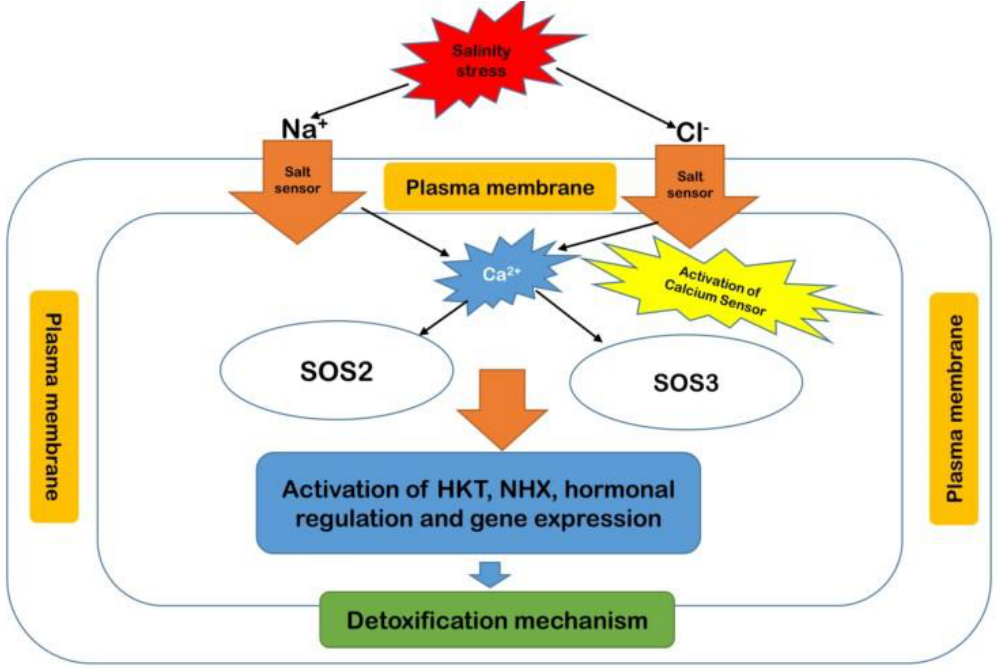
Figure 8. The proposed model of the salt overly sensitive (SOS) pathway for salinity stress tolerance in plants.